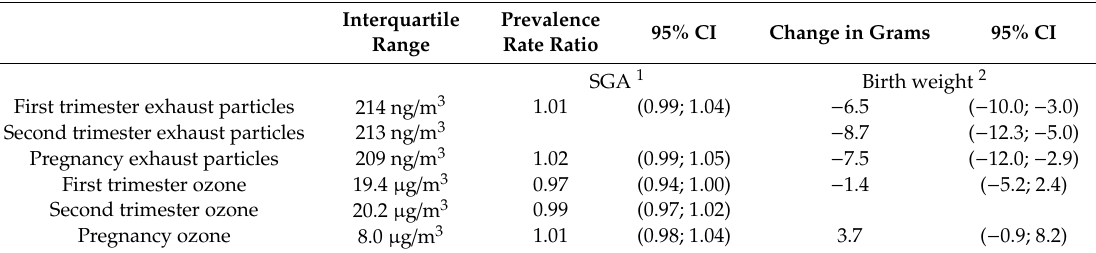
Figure A4. Unadjusted associations between PM-exhaust ( a – c ) and ozone (O 3 ) ( d – f ) during di ff erent stages of gestation and birth weight. Table A2. Linear associations between air pollutants (exhaust particles and ozone) and the outcomes (small for gestational age (SGA) and birth weight).